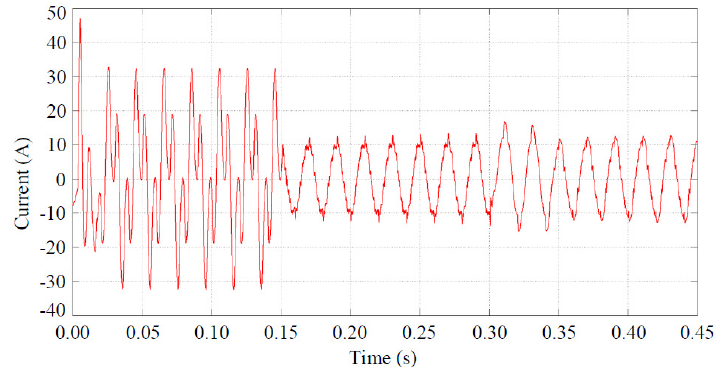
Figure 18. Load 1 neutral current i L 1 N .